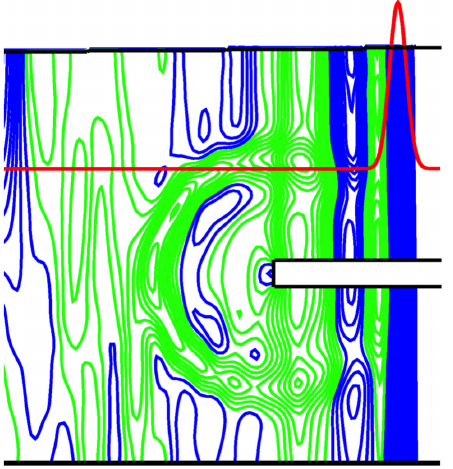
FIG. 2. Electromagnetic field line distribution at the time when a short bunch has passed the ougoing pipe connection. The green lines show force lines with an opposite direction in comparison with other force lines shown in blue. The red line shows the bunch line charge density distribution and the bunch